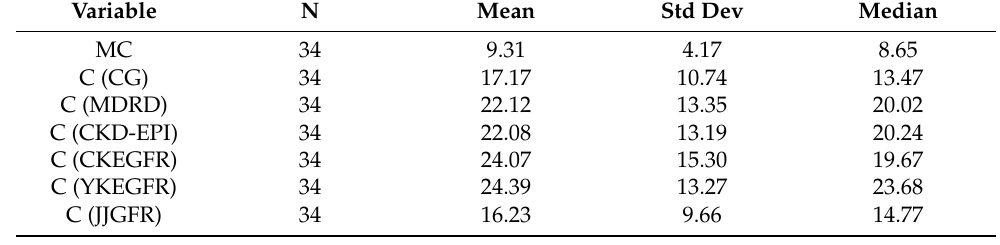
The summary statistics and Spearman’s correlation between the predicted (using SDII models) and measured vancomycin concentrations are presented in Table 2, Figure 2 and Table 3. Table 2. Summary statistics of the predicted (C) and measured concentrations (MC) of vancomycin (VCM) with individual pharmacokinetic (PK) models based on different GFR estimators. Variable